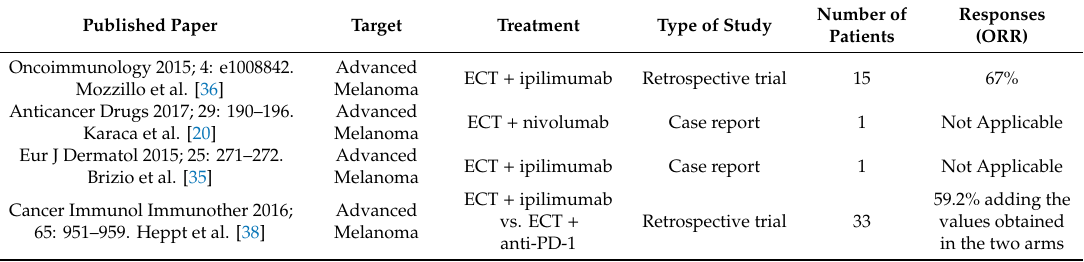
Table 1. Literature findings concerning studies of electrochemotherapy (ECT) +